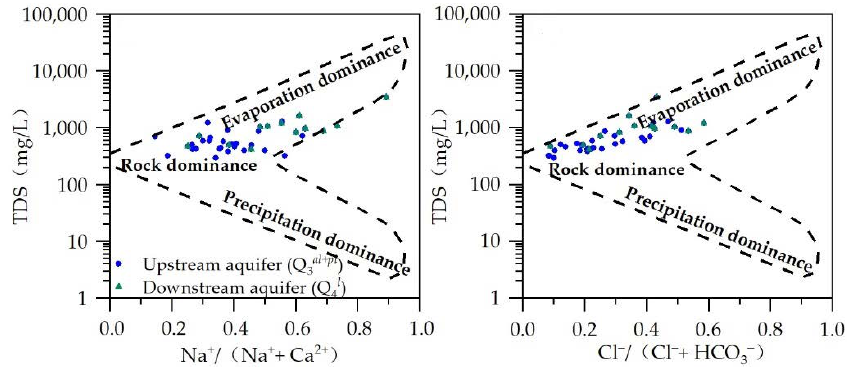
Figure 5. Gibbs diagram of